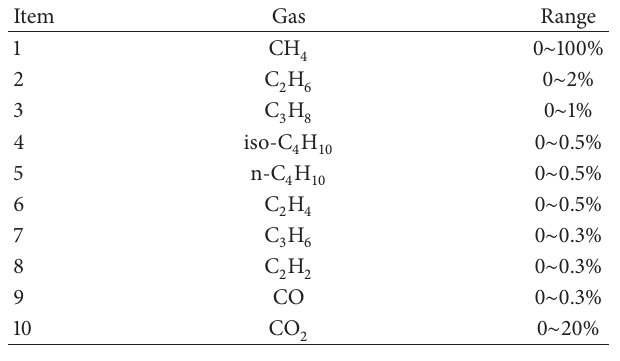
Table 1: Concentration range of every component of analyte (percent by volume).